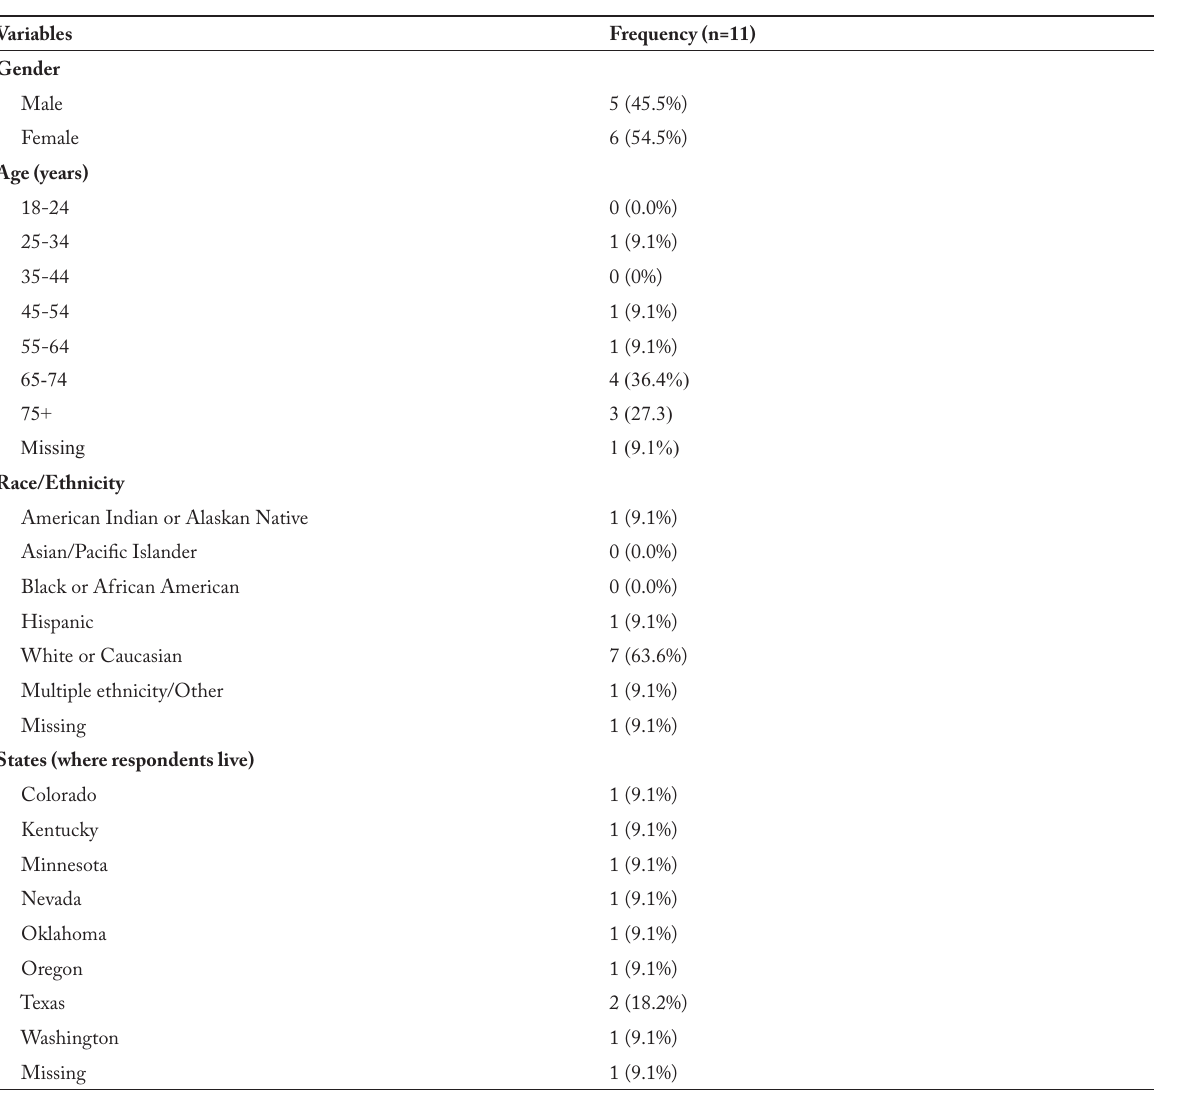
Table 2. Descriptive characteristics of web-based survey